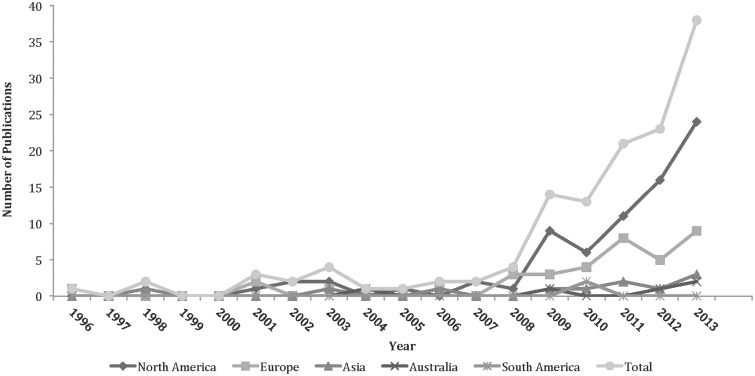
Number of publications per continent over time.